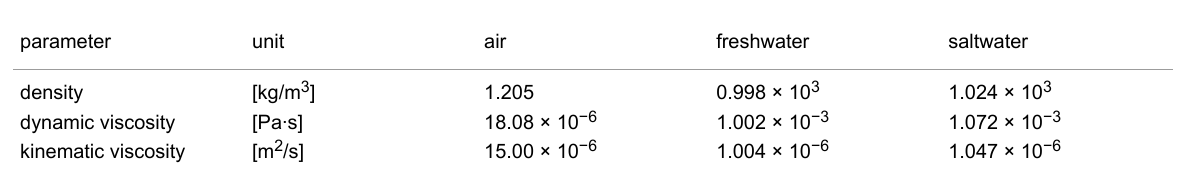
Table 2: Density and viscosities of air and water at 20 °C.